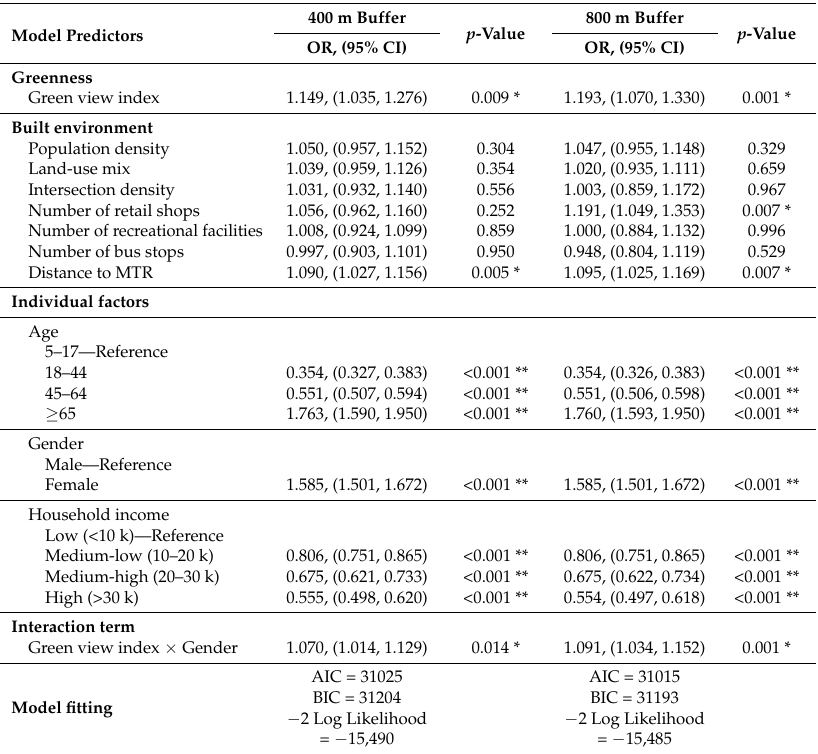
Table 2. Multilevel logistic regression analysis for the relationship between greenness and built environment and individual factors, and the odds of walking in analysis 1; n =